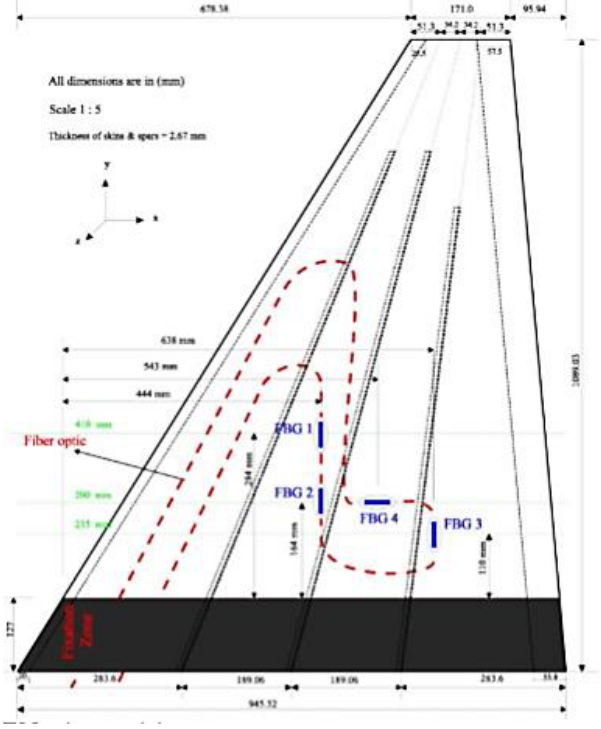
Figure 12. T38 wing model with the embedded FBG sensors